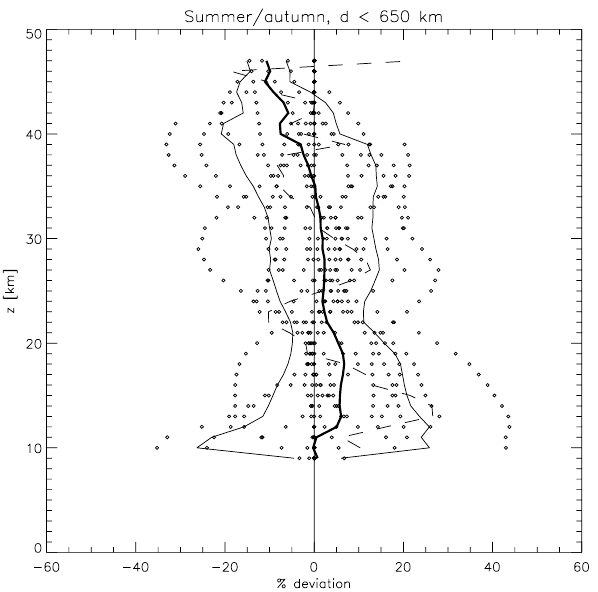
Fig. 5. As Fig. 3, with 650km radius, but only for winter/spring (end of February to early